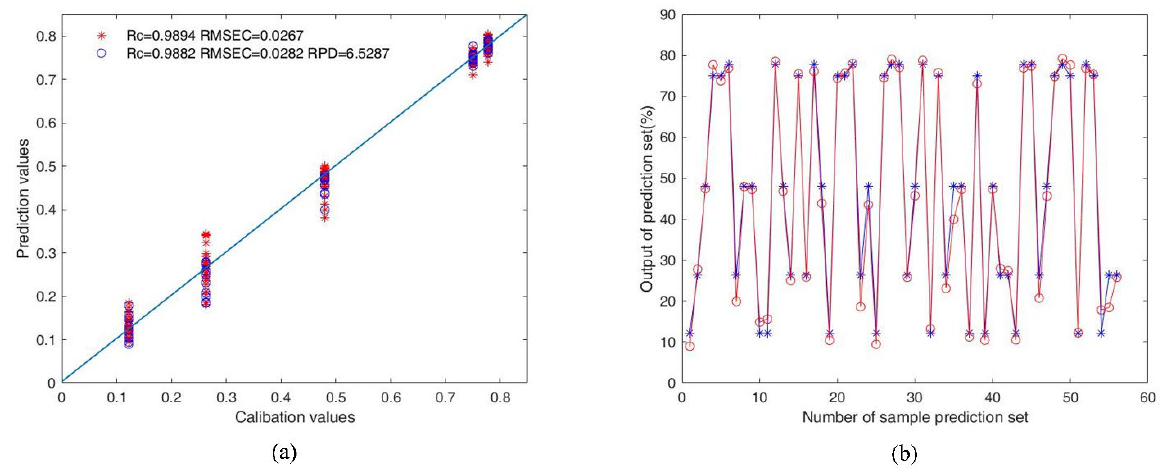
Figure 7. Model optimization based on mid-level data fusion ( a ) scatter plots of the PLS models-based